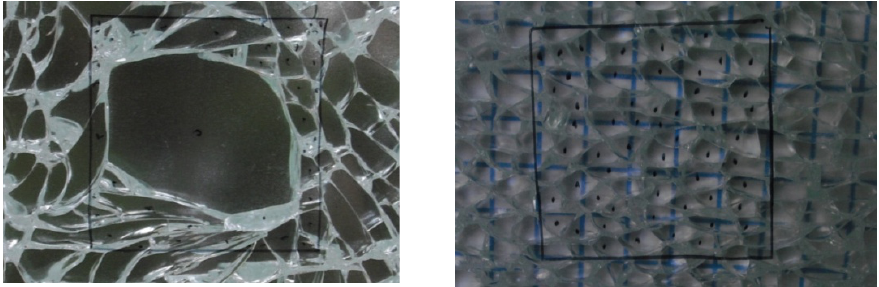
Figure 8a and b: Breakage pattern of curved thermally toughened glass panels (8a: not conform, 8b: conform to DIN EN